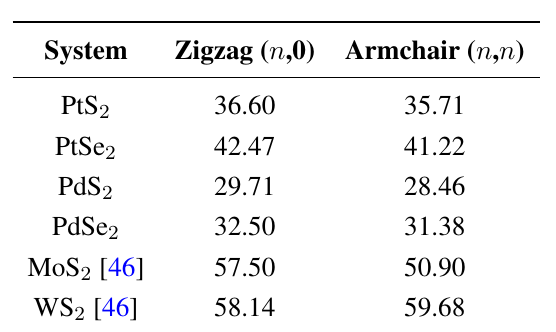
Table 1. Coefficients C ( in eV Å 2 ) of the fitted curves E